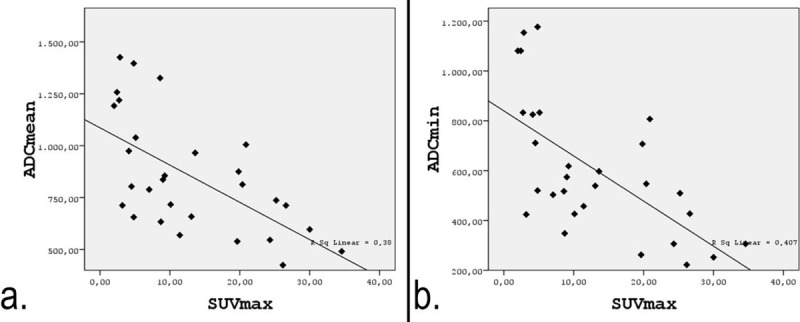
Correlations between the SUVmax and both ADCmean (a) and ADCmin (b).